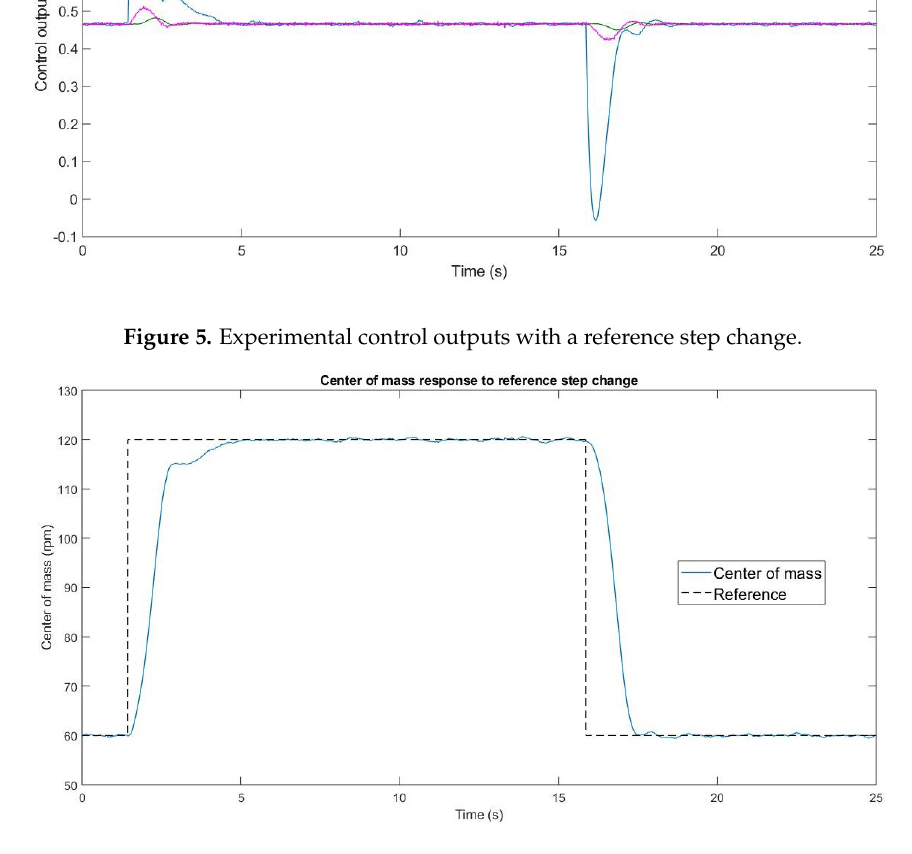
Figure 6. Experimental state center of mass with a reference step